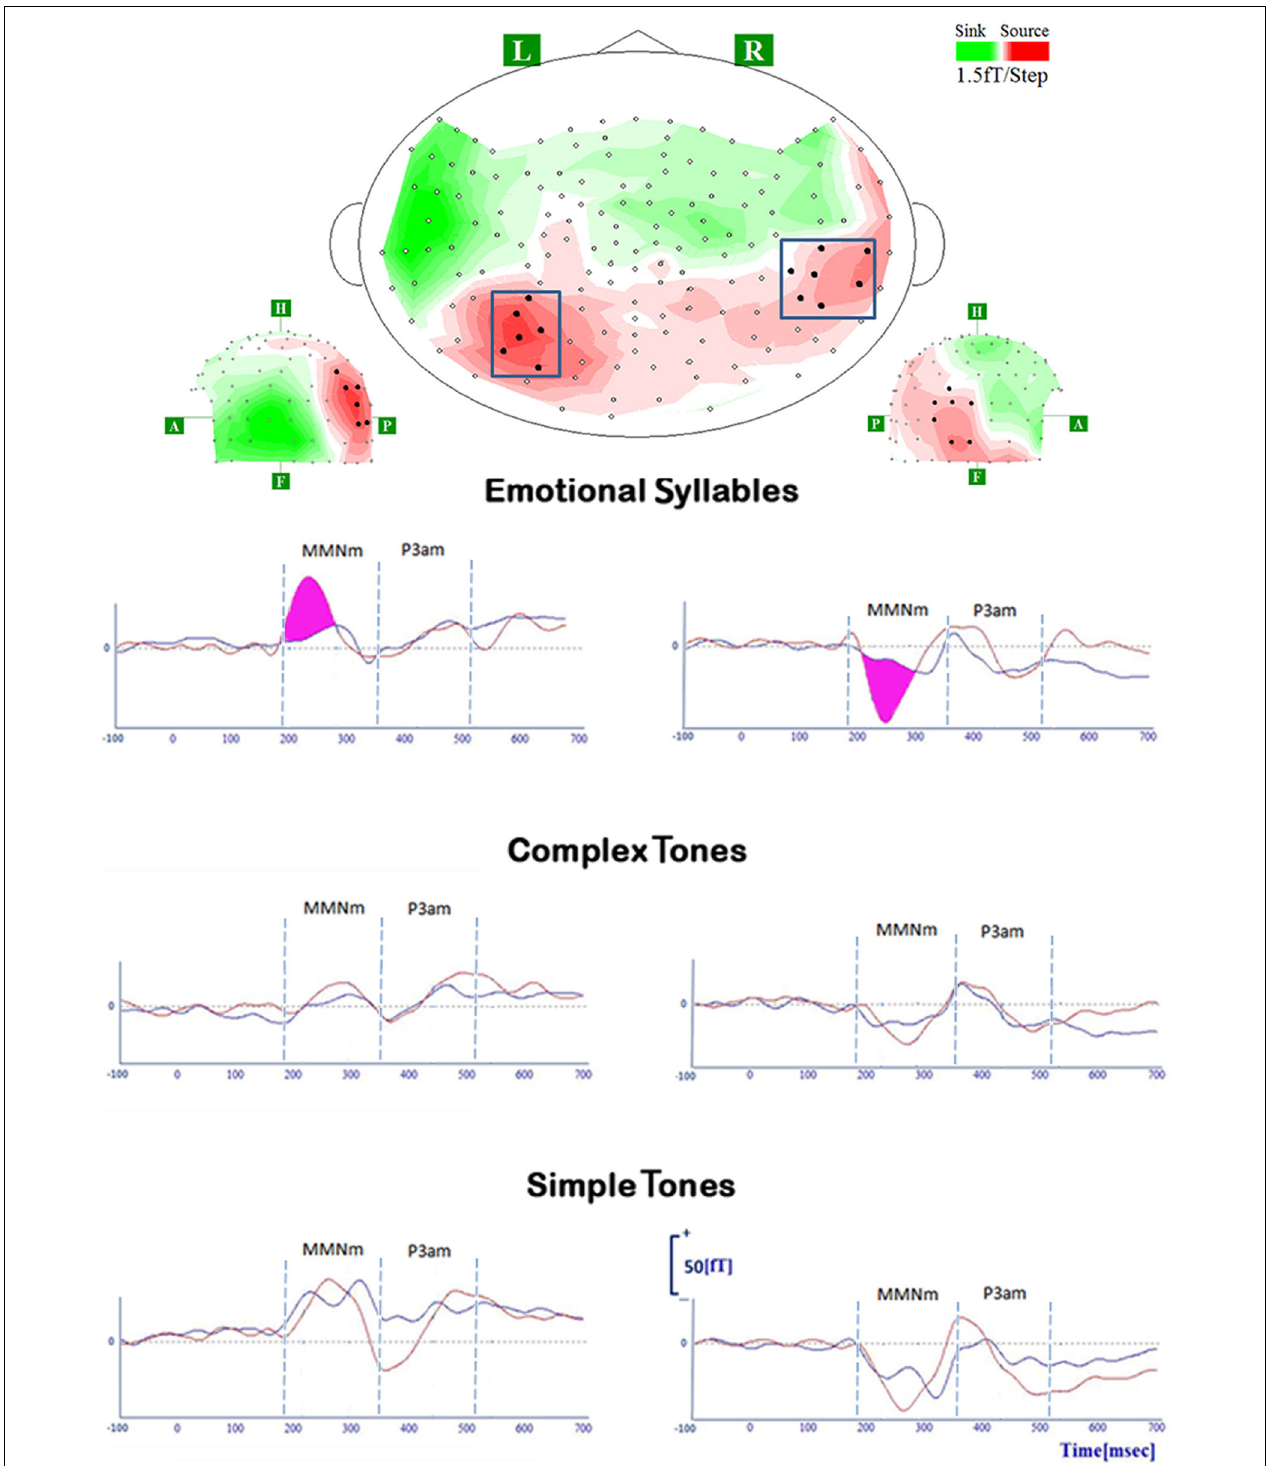
FIGURE 4 | MMNm and P3am in response to deviant stimuli of emotional syllables, complex tones, and simple tones. All deviant stimuli of each category (emotional syllables, complex, and simple tones) consistently elicit MMNmand P3am [red line: disgusted MMNm(D2-S); blue line: happy MMNm